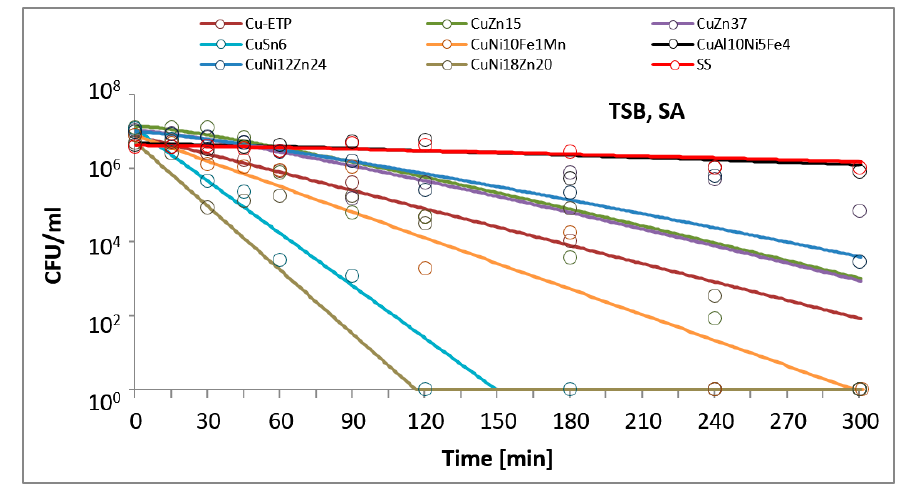
Figure 3. Staphylococcus aureus (SA) suspension density (CFU/mL) reduction on tested metallic materials, in the variant of the experiment simulating organic contamination. TSB, tryptic soy broth.